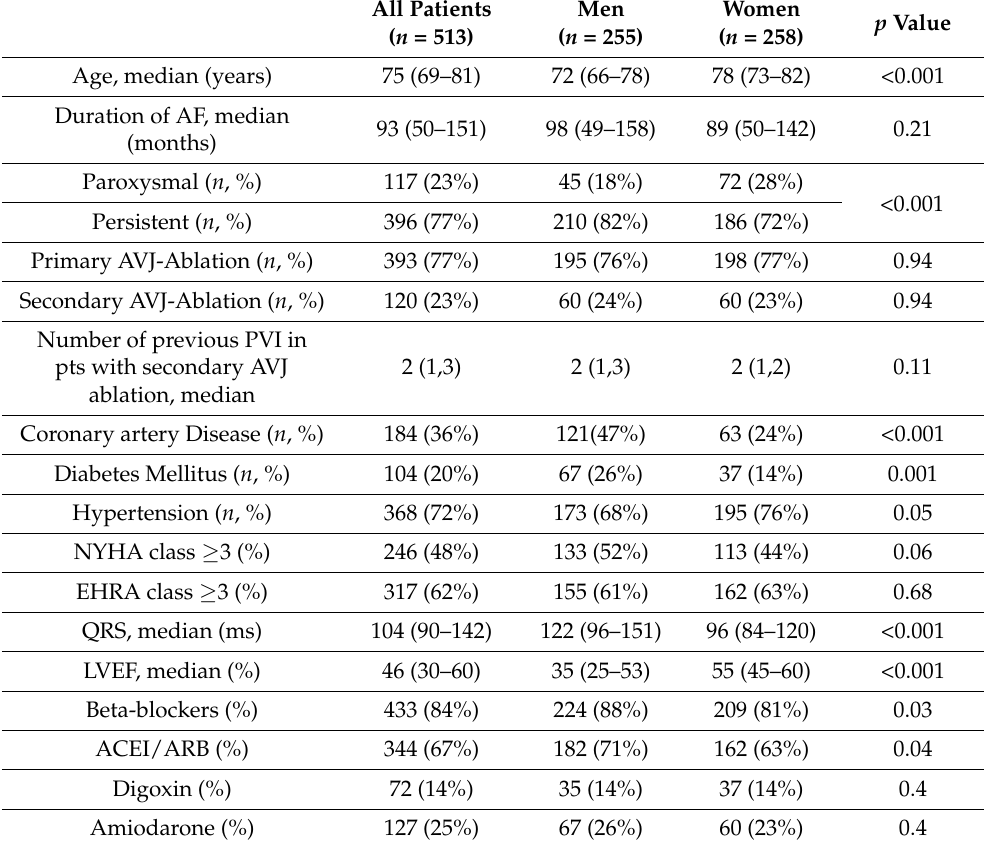
Table 1. Baseline characteristics of the